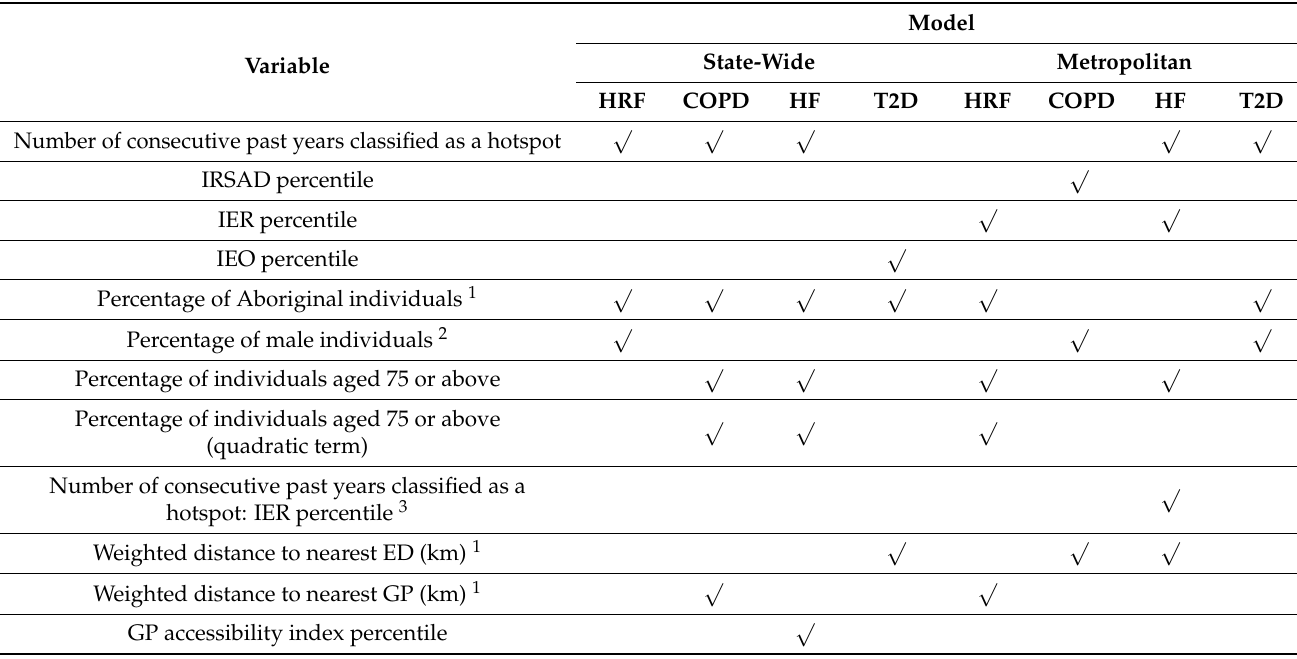
Table 3. Presence of predictors in the optimal state-wide and metropolitan models for high-risk foot (HRF), chronic obstructive pulmonary disease (COPD), heart failure (HF), and type II diabetes (T2D). Model State-Wide Metropolitan Variable HRF COPD HF T2D HRF COPD HF